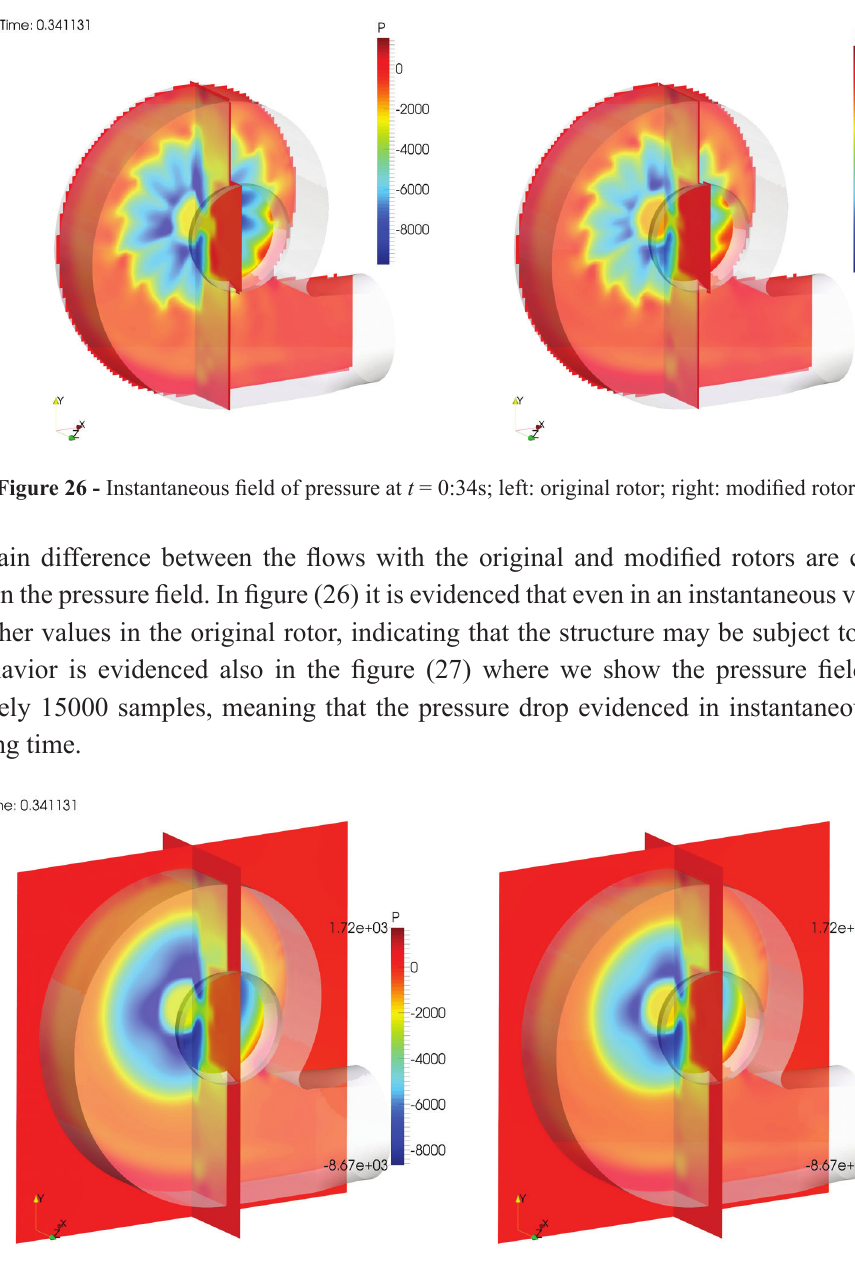
Figure 27 - Averaged field of pressure; left: original rotor; right: modified